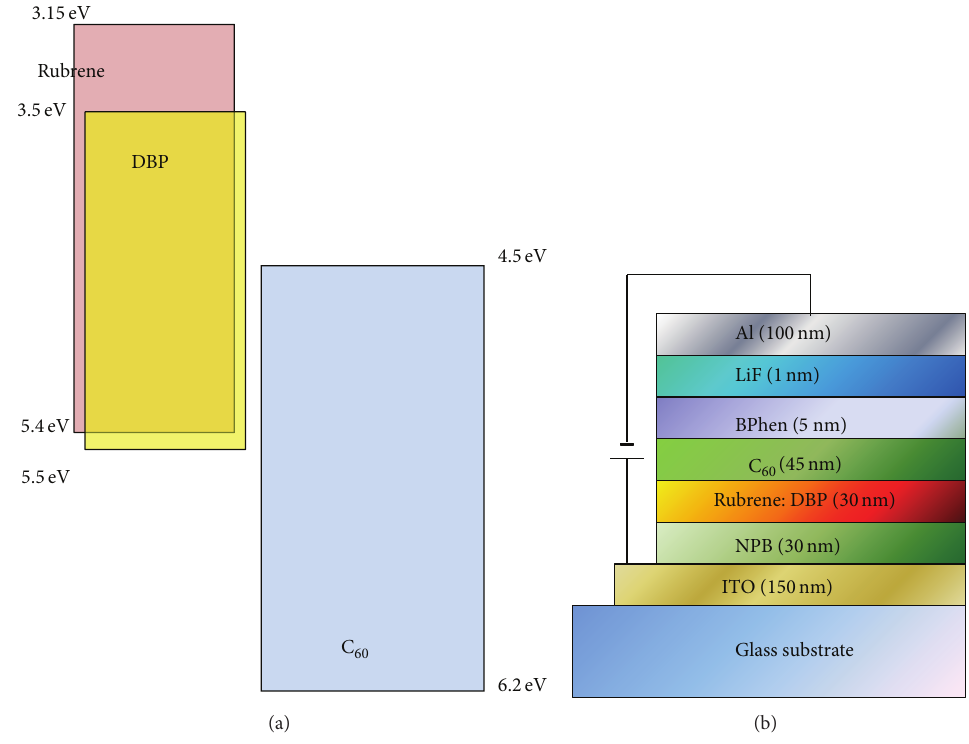
Figure 2: Schematic diagram showing (a) the energy bands of the junction materials and (b) the stacked structure of the